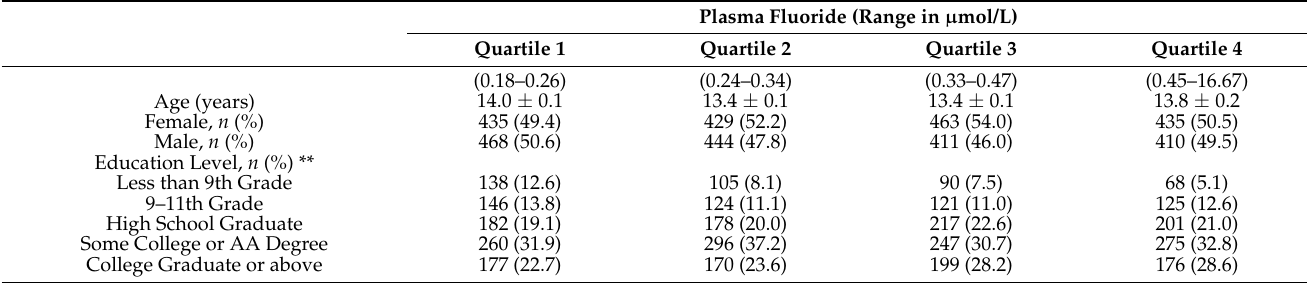
Table 1. Characteristics of the study population across quartiles of plasma fluoride ( n = 3495)